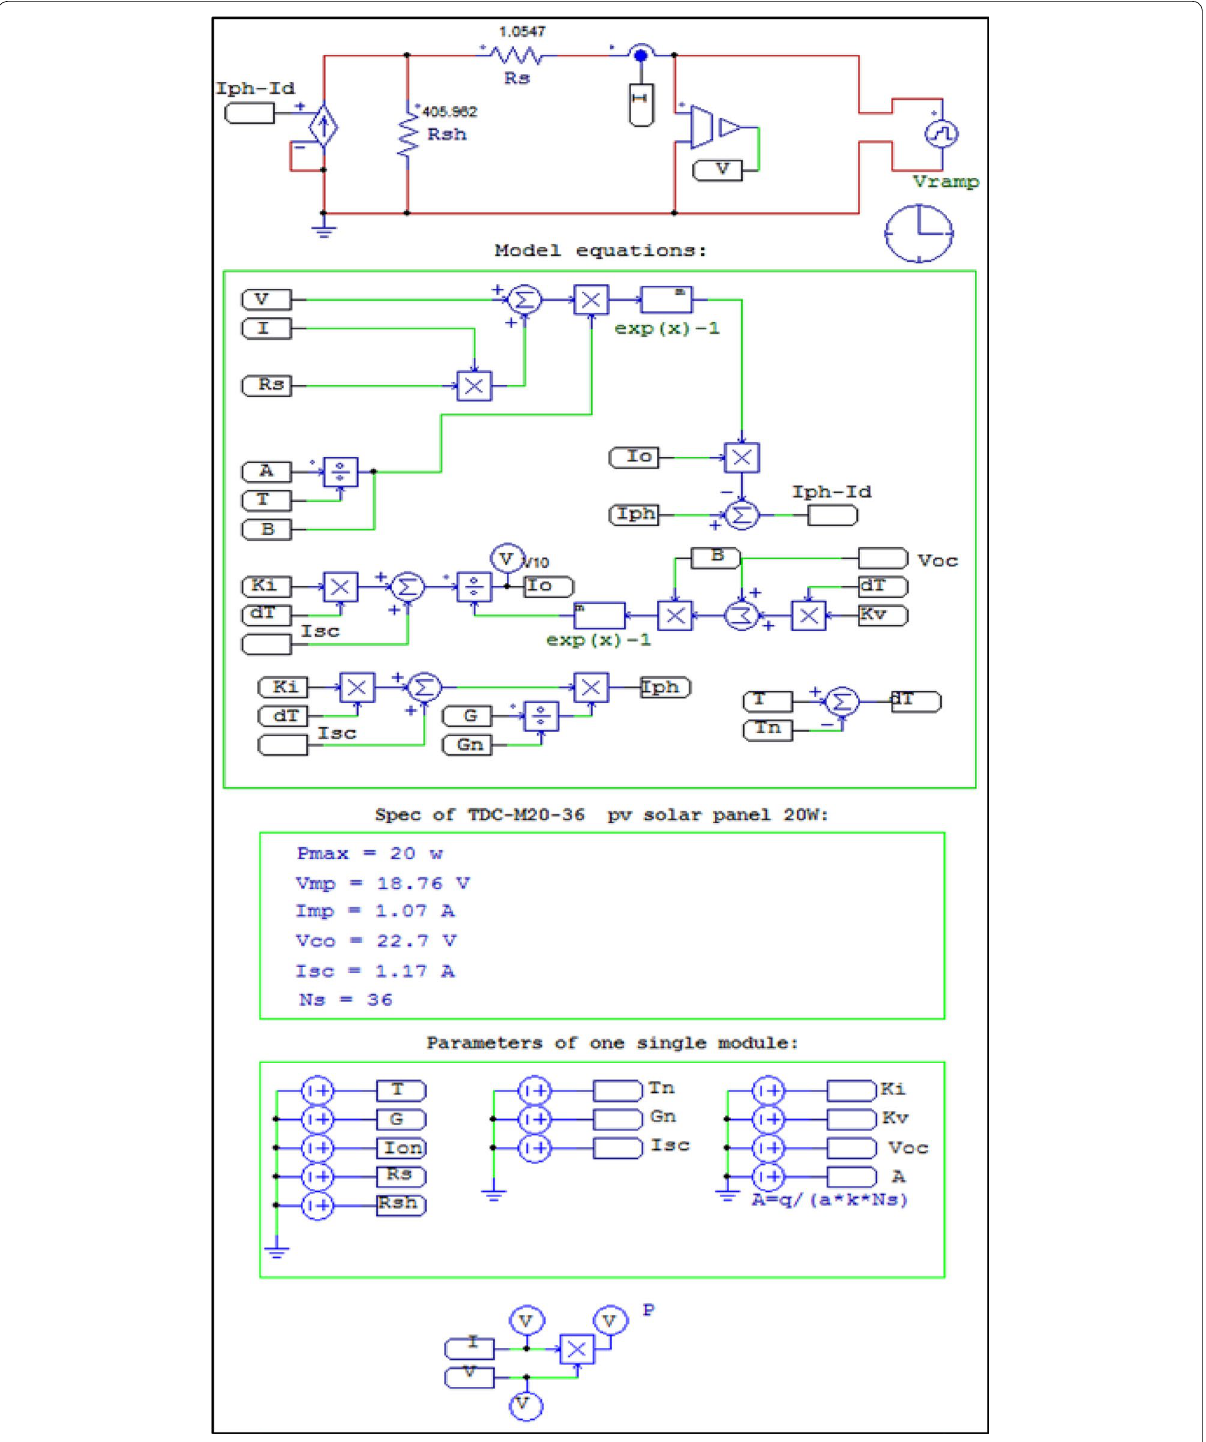
Fig. 2 The PSIM model of PV